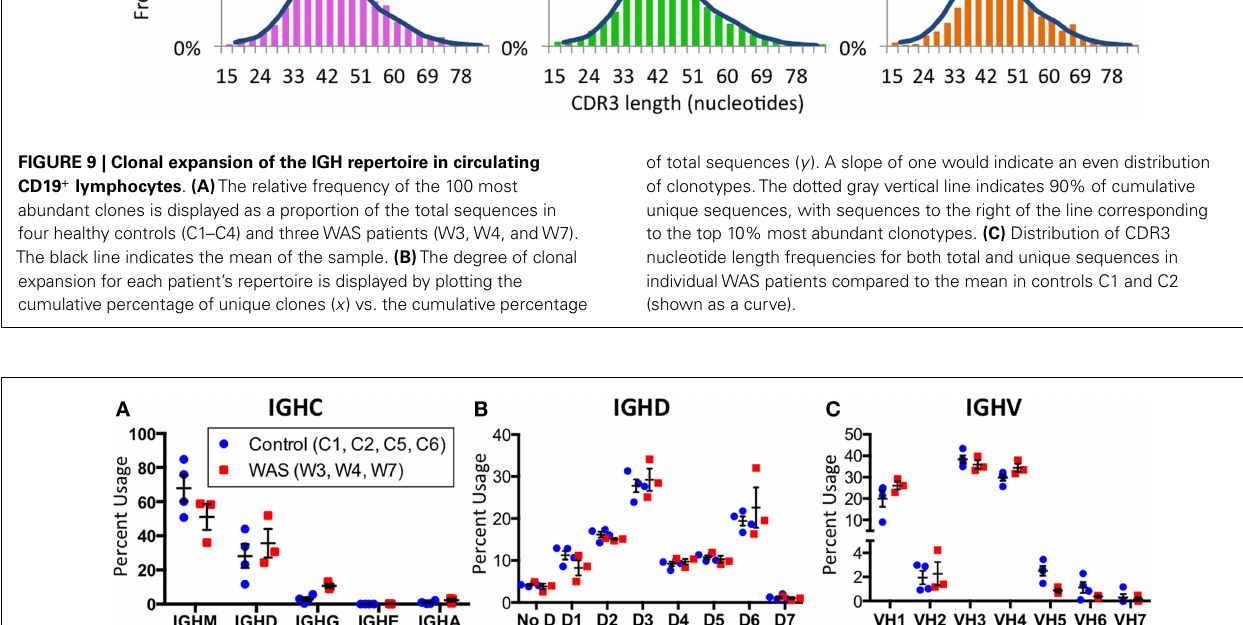
FIGURE 10 | Usage of IGHV , IGHD , and IGHC families in circulating B cells from controls andWAS patients . Percent usage of V (A) , D (B) , and constant (C) segment families in unique IGH clonotypes is shown for both controls (blue dots) andWAS patients (red squares). Bars indicate the mean and SE.